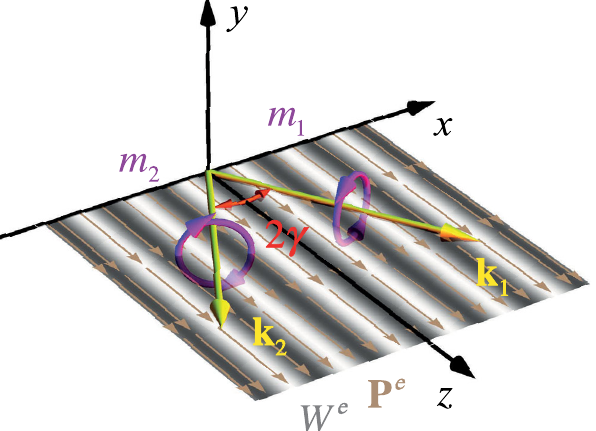
FIG. 1. Interference of two polarized plane waves. Two waves having equal amplitudes and wave vectors k 1 with an angle 2 γ ; 2 between them propagate and interfere in the ð x; z Þ plane. The wave polarizations are characterized by complex parameters m 1 , and here the case of opposite circular polarizations m 1 ¼ ; 2 − m σ − σ 1 ) is shown. 2 ¼ i (i.e., the Stokes parameters 1 ¼ 2 ¼ Here and in Figs. 2 and 3, the gray scale plot represents the distribution of the electric energy density W e ð x Þ , Eqs. (4) and (9). The in-plane brown arrows show the electric part of the canonical momentum density of light P e ð x Þ , Eqs. (5) and (10). This canonical momentum determines the energy transport and the optical pressure, and it is directed along the z axis independently of the wave